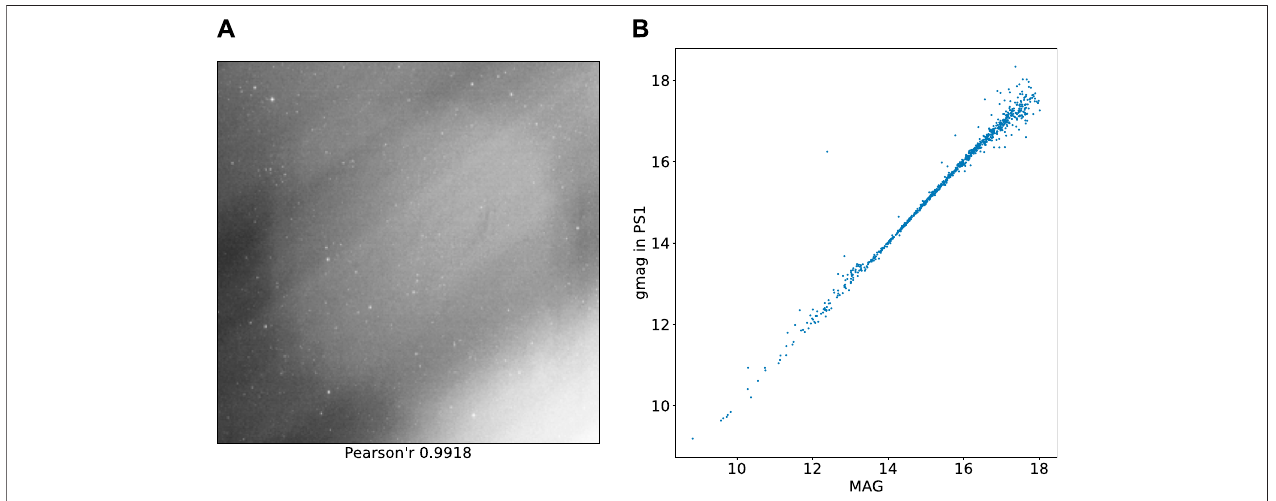
FIGURE 2 | (A) shows the thumbnails of an AST3-3 image with obvious cloud effects. (B) is a scatter plot of the calibrated aperture photometry magnitude and g-mag in PS1.